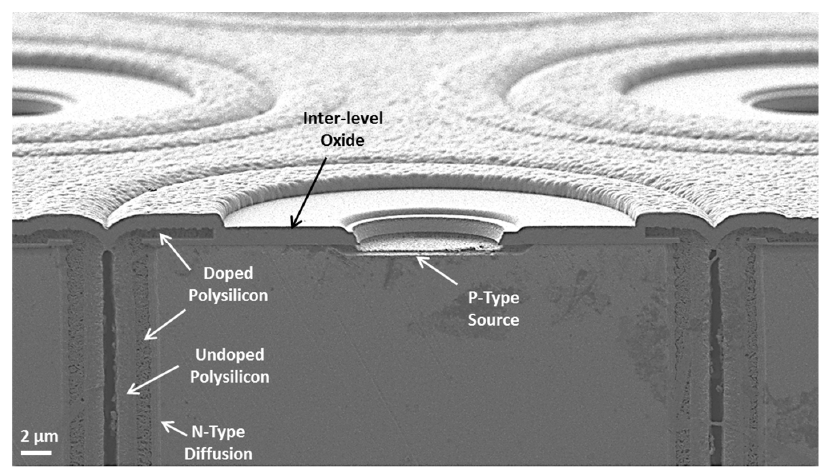
Figure 6. SEM image of a cross section through the center of an individual V-JFET cell, obtained on a sample during the fabrication process. Regions with different doping levels are distinguishable thanks to a preparation of the sample with a reverse engineering technique.